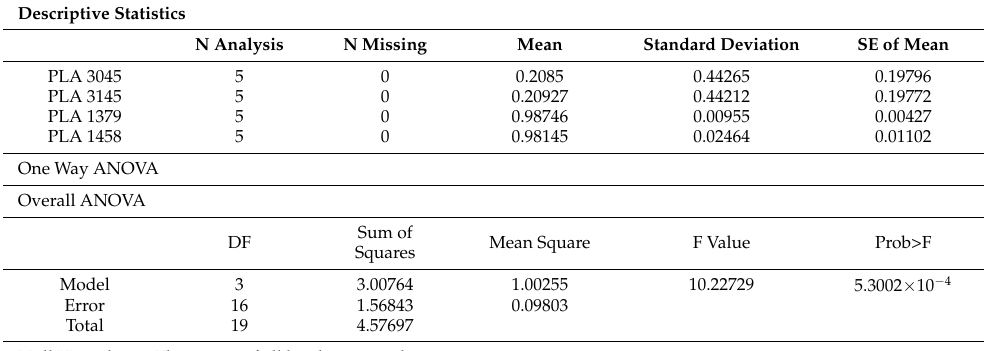
Table 5. One-way ANOVA for PHB samples under UV radiation at 0, 2, 5, 24, and 144 h.